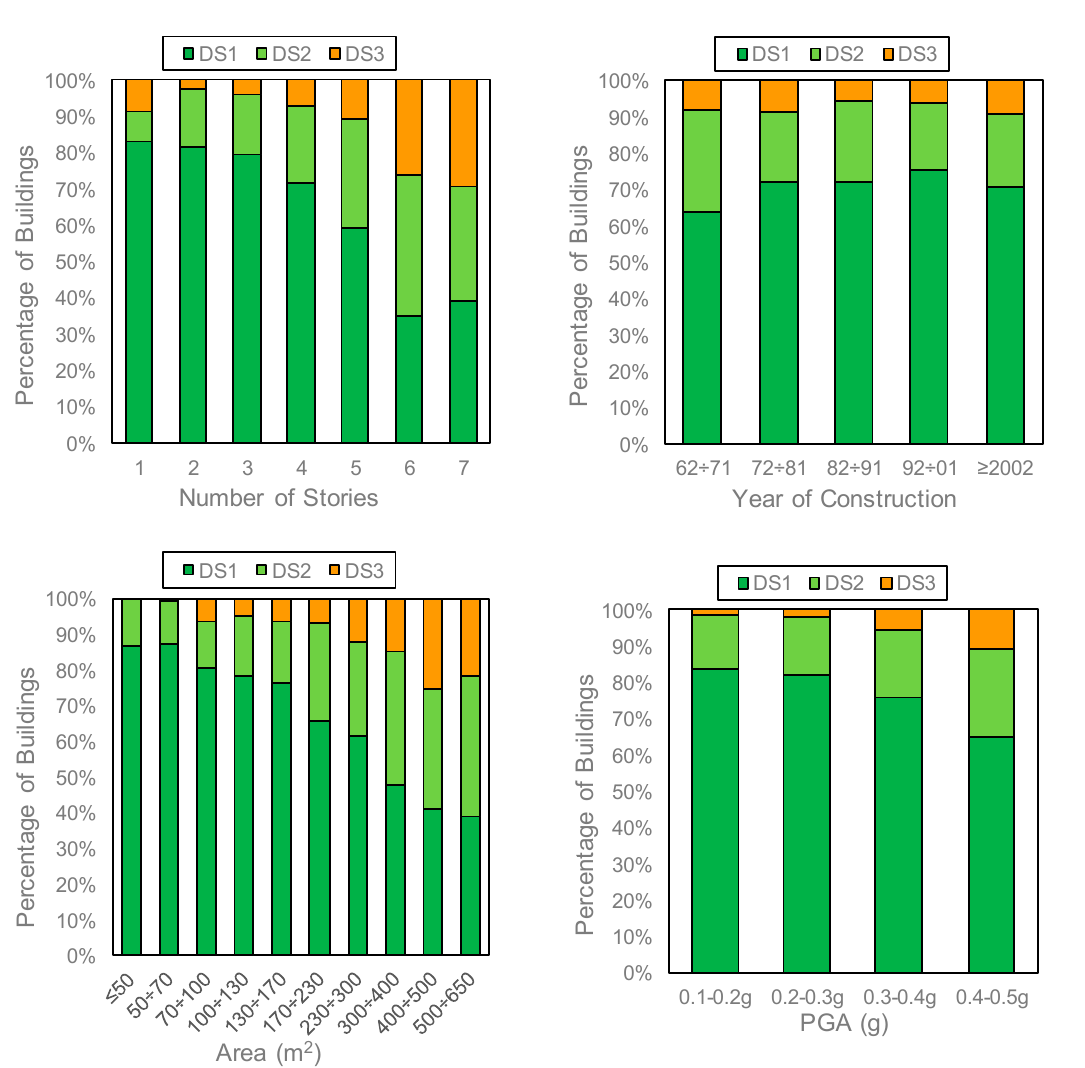
Figure 10. Analysis of the observed damage scenario for “lightly-damaged” RC buildings depending on the PGA of the event, year of construction, number of storeys and plan area of the buildings.